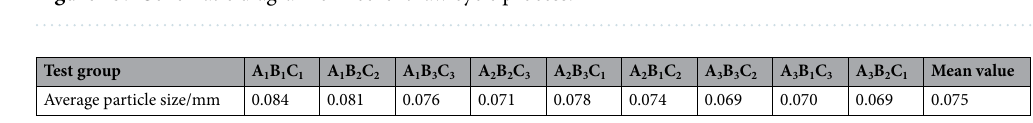
Table 10. Average particle size of SEM image of dry shrinkage orthogonal test sample.